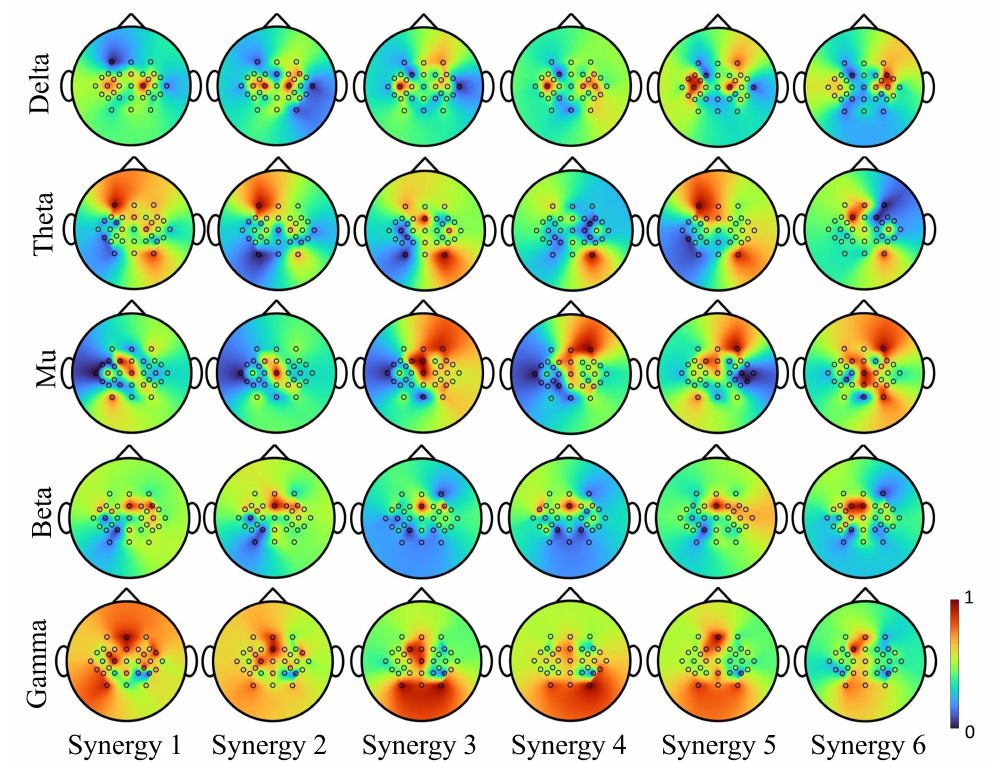
Figure 10. Synergy modulation in delta, theta, mu, beta and gamma frequency bands of EEG. Synergies activation mainly concentrated on the primary motor area modulated in low-frequency rhythm (delta). In theta rhythm, strong activation was observed on the contralateral premotor cortex, and ipsilateral somatosensory cortex. Mu modulations were observed in the supplementary motor cortex, and beta were observed in the bilateral primary motor region. Activations observed from gamma spanned over all motor-related